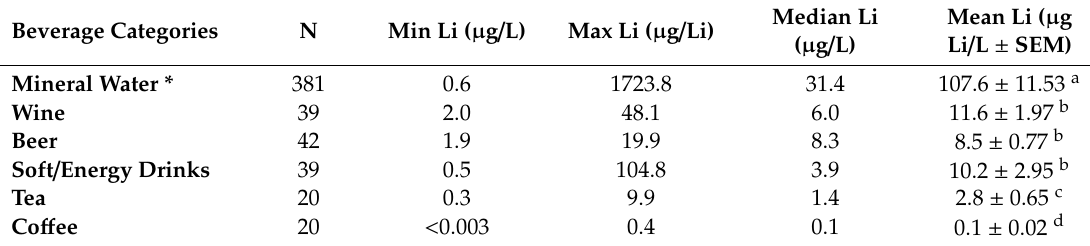
Table 3. (A) Lithium (Li) concentrations in di ff erent beverage categories. Li content was analysed in wine ( n = 39) and beer ( n = 42), soft and energy drinks ( n = 39) as well as tea ( n = 20), co ff ee ( n = 20). The average Li content of mineral water ( = 108 µ g / L) was set as a reference value. Li concentrations were measured by inductively coupled plasma mass spectrometry